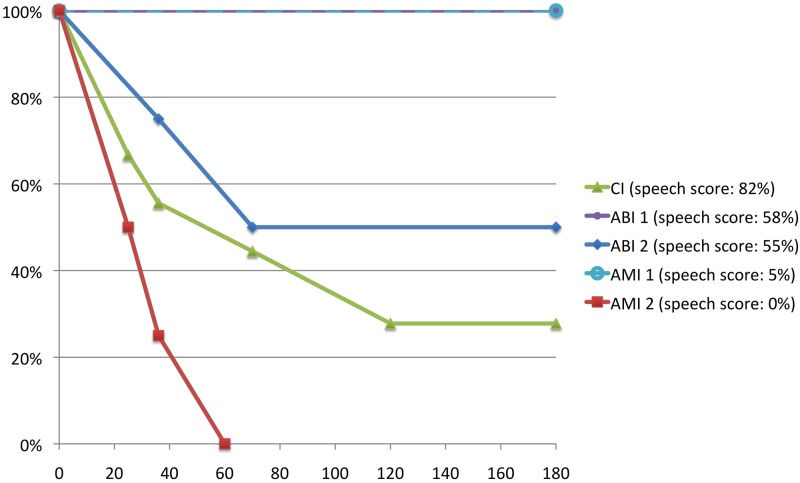
Time course of loudness adaptation in auditory implant users.Ordinate displays the percentage relative to comfortable loudness that is maintained over time (in seconds along the abscissa) in response to continuous multi-tone complex stimulation. Speech perception scores for each implant user taken from Table 1 are listed in the legend to the right of the figure.